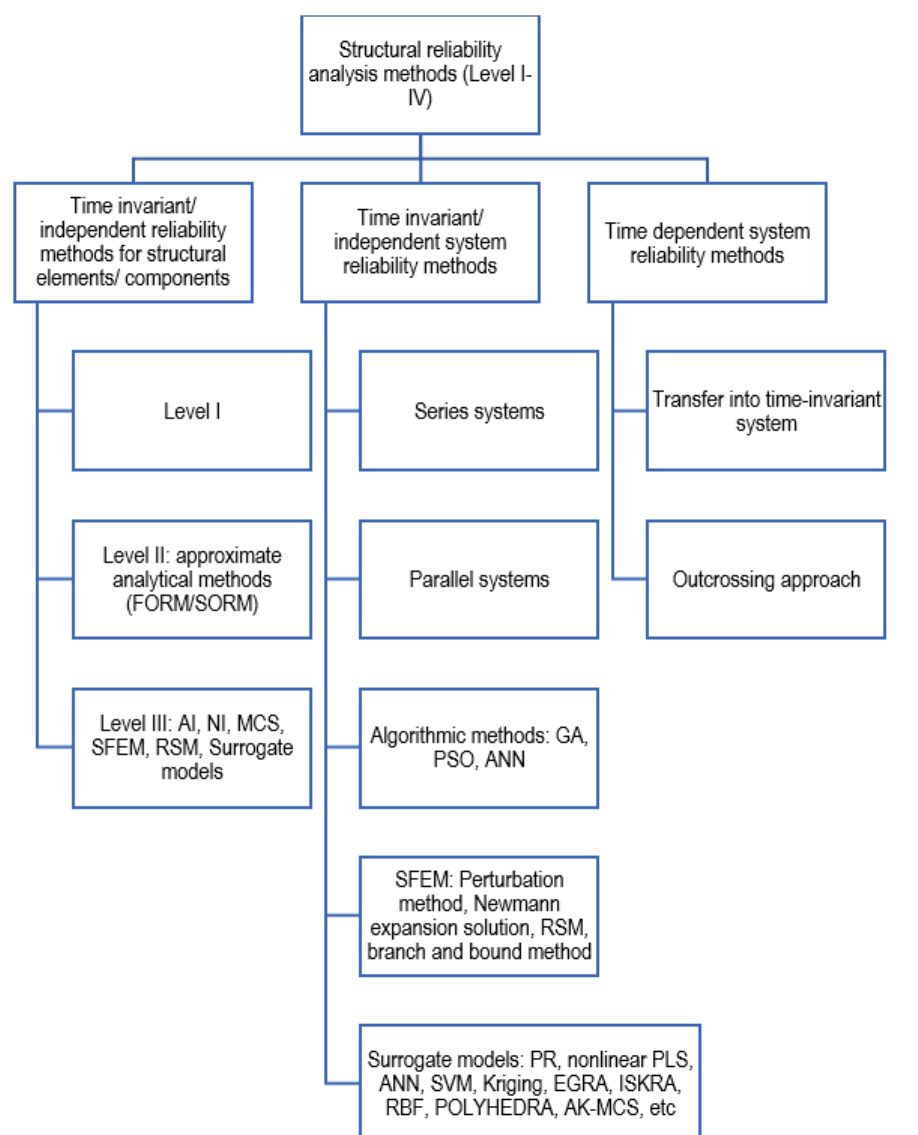
Figure 2. Methods for Structural Reliability Analysis [7,8,14,15], LSF: Limit State